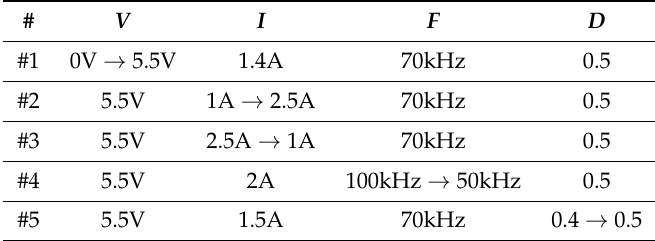
Table 3. Switch-mode power supply (SMPS) operating conditions during transient